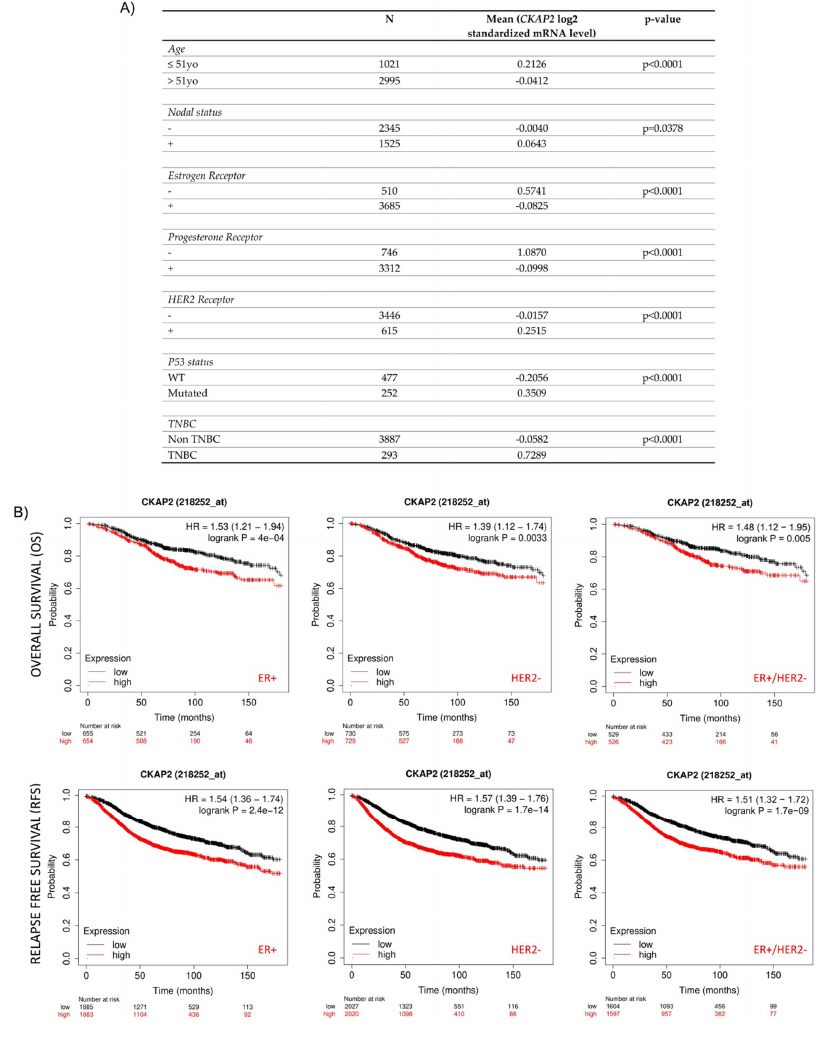
Figure 4. Correlation of CKAP2 expression with clinicopathological parameters and patient survival. ( A ) Relationship between CKAP2 mRNA expression and clinicopathological parameters (such as age nodal status, receptor status, p53 status, and triple-negative status) of BC generated from bc-GenExMiner. N: number of cases. ( B ) The prognostic value of CKAP2 in BC patients was plotted from KMplotter. CKAP2 expression and prognosis in BC patients were analyzed for relapse-free survival (RFS) and overall survival (OS). ER: estrogen receptor status; HER2: human epidermal growth factor receptor; HR hazard ratio. Data with p < 0.05 were considered statistically significant.